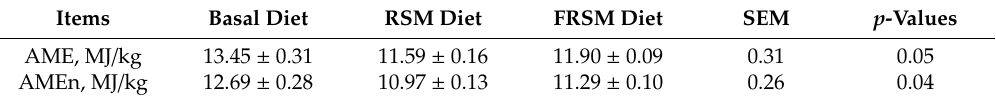
Table 6. Metabolizable and nitrogen corrected metabolizable energy of basal diet (dry matter basis). Items